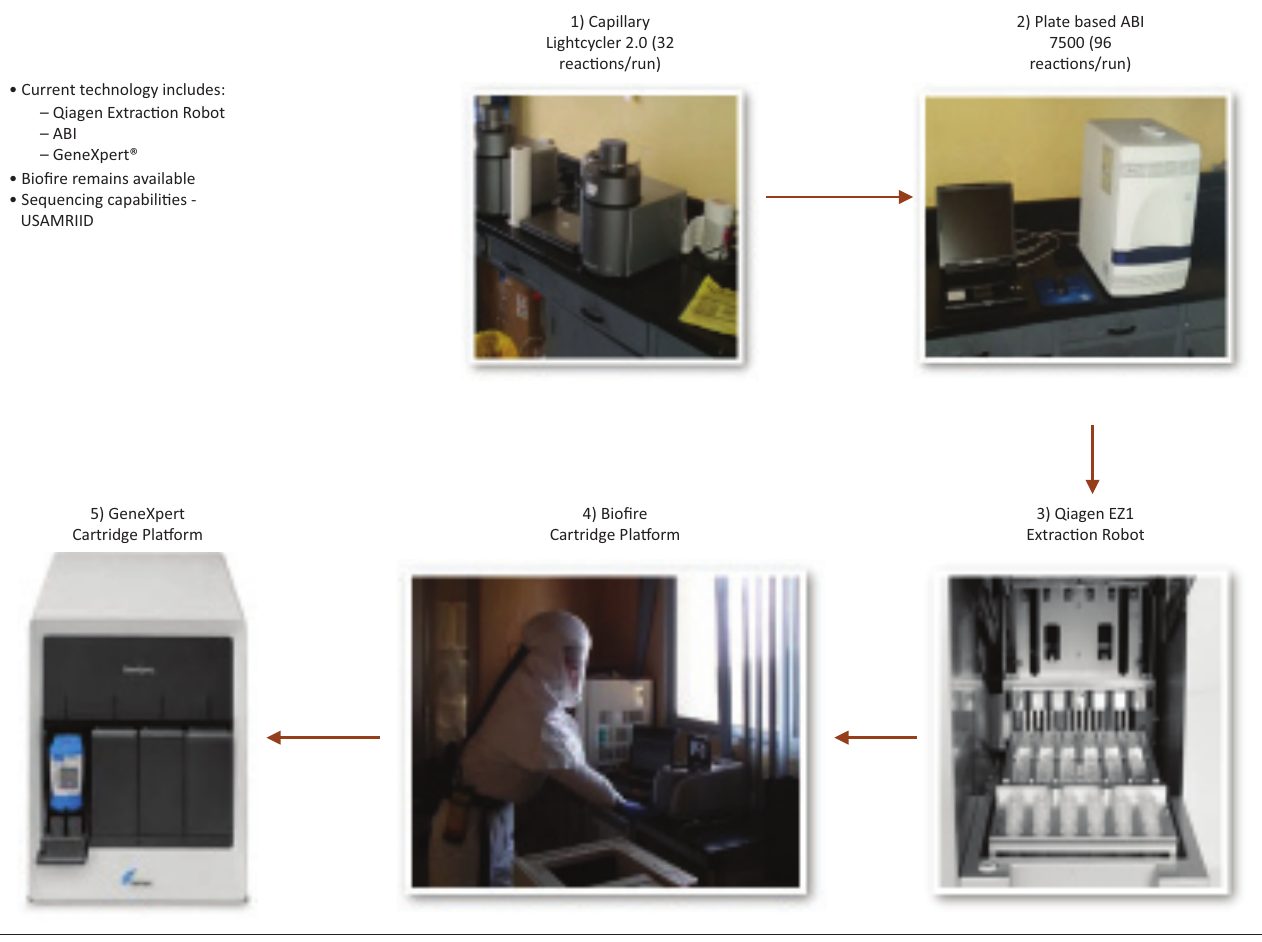
FIGURE 1: Post-Ebola virus disease technology